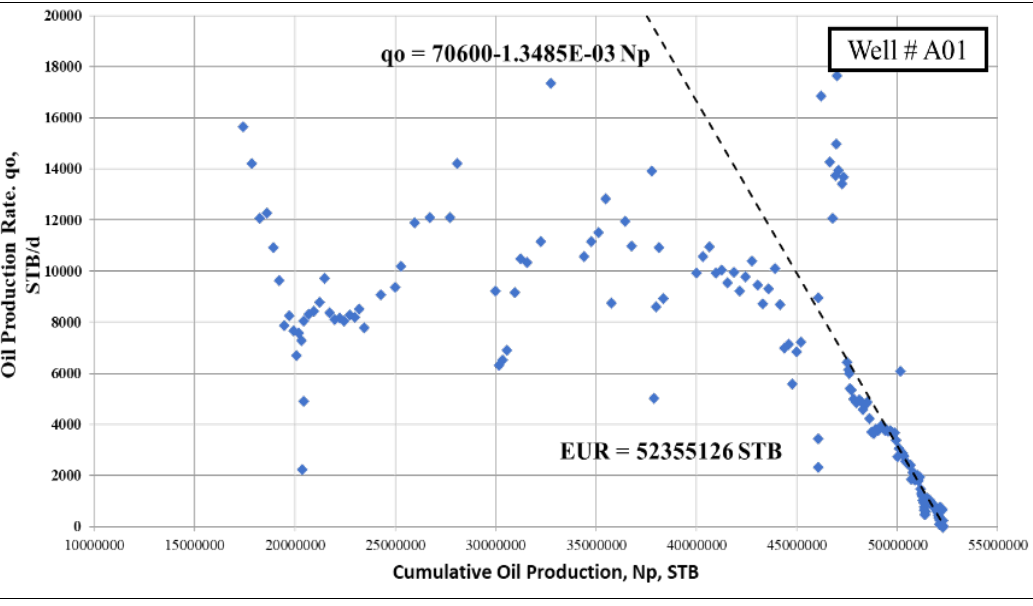
Figure 5. Oil production rate versus cumulative oil production for well